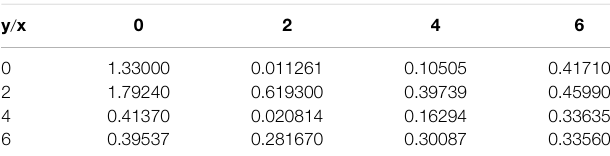
TABLE 4 | Positive surface data from function F 1 ( x , y )